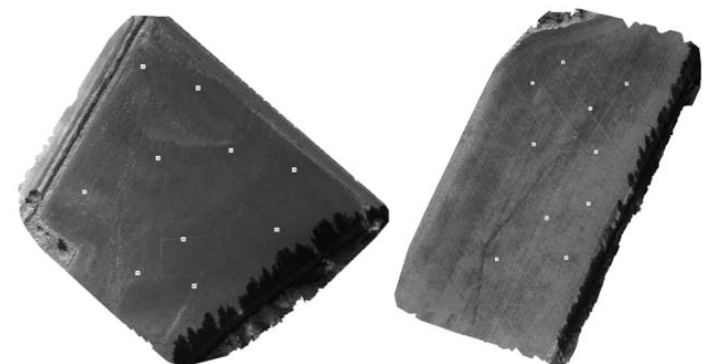
Figure 3. Orthomosaic pictures from the NIR spectral band. In the images, the multiple white squares are the ten measurement points of the crop properties. The image of the Mölylä field (left) was taken on 31 July 2019 at 12:00 and the image of the Koirasuo field (right) on 1 August 2020 at 12:00.